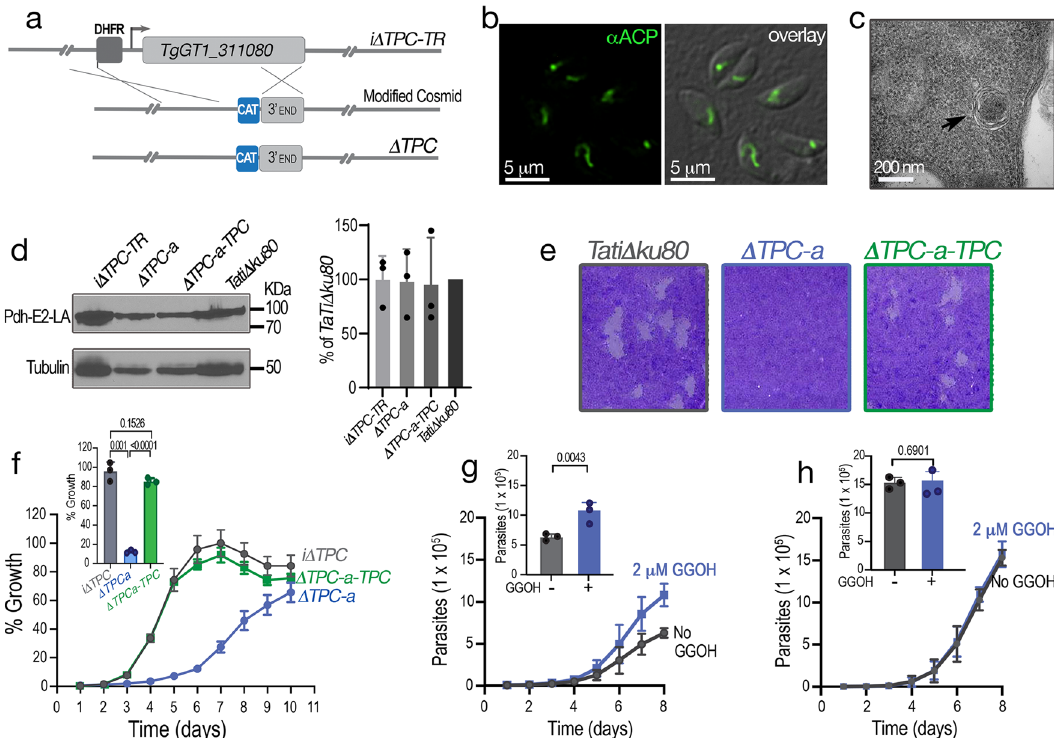
Fig. 5 TgTPC regulates replication independent of apicoplast biogenesis. a The TgTPC gene was deleted in the i Δ TPC-TR parasites by using a cosmid strategy. The knockout cosmid construct was engineered in E. coli by replacing the 5 ′ terminus of the TPC gene with a chloramphenicol selection cassette. The construct containing the CAT selection cassette was transfected into the i Δ TPC-TR parasites to replace the DHFR cassette plus 5 kb of the TPC gene by homologous recombination, generating TPC null mutant. b Δ TPC-a cultured for 12 months show apicoplast labeling by IFA with the marker α ACP (1:200). N = 3. c Transmission electron microscopy of Δ TPC-a showing the characteristic apicoplast with four membranes. N = 2. d Lipoylation of PDH-E2 detected by western blot with an anti-lipoylated-PDH-E2 antibody (clone3H-2H4 1:1,500 dilution). N = 3, mean ± SD. e Plaque assays showing growth of control cells, Tati Δ ku80 , compared with Δ TPC-a and Δ TPC-a-TPC . Con fl uent fi broblast cells grown in 6 well plates were infected with 150 tachyzoites of the indicated cell lines for 8 days. N = 3. f Growth of fl uorescent clones of i Δ TPC, Δ TPC and Δ TPC-a-TPC cells in fi broblasts in 96-well plates at 4000 parasites/ well. The % of growth of each indicated cell line was normalized to growth of i Δ TPC (no ATc) at day 7 (considered 100%). Inset shows the quanti fi cation of three independent experiments at day 6. Error bars represent the standard deviation (SD) of the three experiments analyzed. Δ TPC-a versus i Δ TPC , p = 0.0001; Δ TPC-a versus Δ TPC-a-TPC , p < 0.0001; Δ TPC-a-TPC versus i Δ TPC, p = 0.1526 . N = 3. Data are presented as mean ± SD. g Partial rescue of Δ TPC mutants by Geranylgeraniol (GGOH). 4,000 tdTomato expressing Δ TPC-a cells were used to infect each well of a 96 well plate in the presence or absence of 2 µ M of GGOH. Growth was monitored daily for 8 days. N = 3. Inset shows the quanti fi cation of three independent experiments at day 8. p = 0.0043. Data is presented as mean ± SD. h same protocol as in g with 200 RH parasites. Growth was monitored daily for 8 days. Inset shows cell numbers on day 8 from 3 independent experiments. N = 3, p = 0.6901. Data are presented as mean ± SD. p value: unpaired two tailed t test performed in all